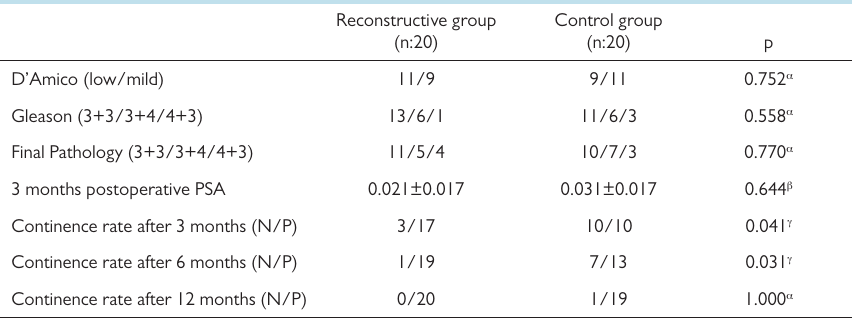
Table 2. Comparison of the D’Amico risk class, Gleason score, final pathology, 3 rd month PSA results, and continence rate at the 3 rd , 6 th , and 12 th months between the